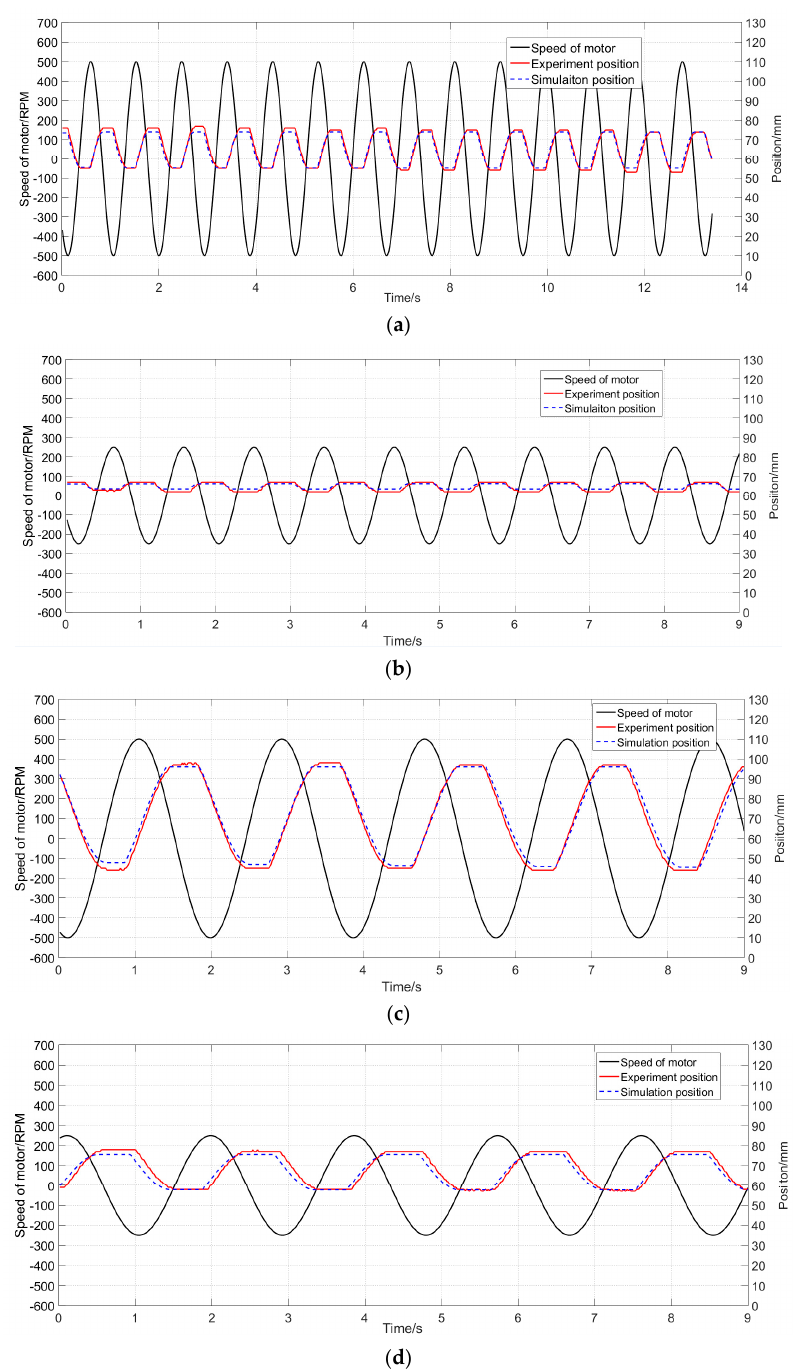
Figure 16. The position output in the open-loop sinusoidal simulation. ( a ) 1 Hz, 500 RPM. ( b ) 1 Hz, 250 RPM. ( c ) 0.5 Hz, 500 RPM. ( d ) 0.5 Hz, 250